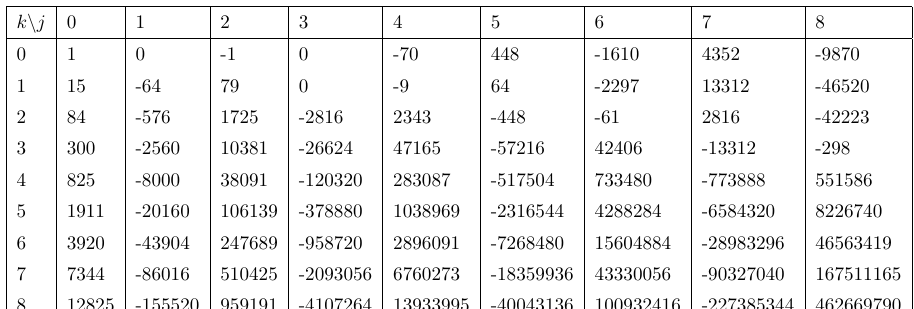
Table 49. Table of b jk coe(cid:14)cients for h SU(4)